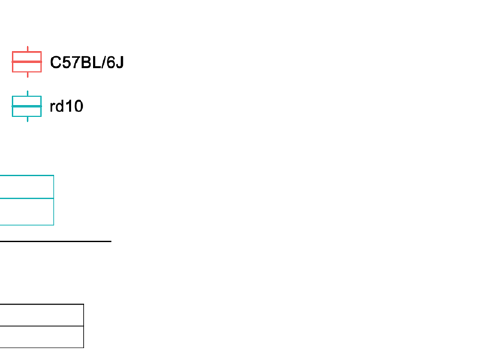
Figure 2. Taxonomic analysis of the mouse gut microbiome. ( a ) Relative abundance (%) at Phylum level for C57BL/J6 and rd10 mice gut microbiota. Dominant phyla were Bacteroidota and Firmicutes in both groups. ( b ) Relative abundance (%) of the most abundant species found in C57BL/6J and rd10 samples. Only species which had at least 1% of relative abundance in one of the samples were represented.